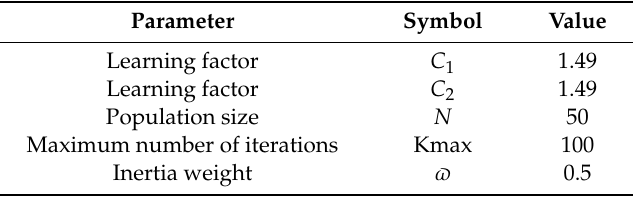
Table 4. Particle swarm optimization (PSO) parameters.